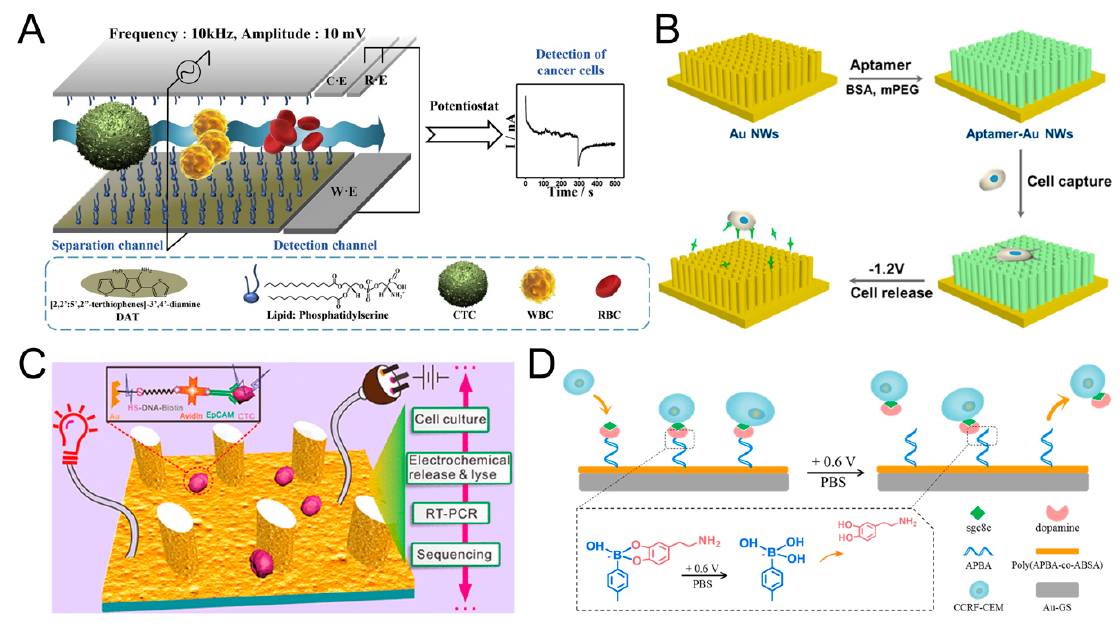
Figure 5. Other electrochemical detection methods of CTC. ( A ) Modified the surface of the channel with lipid bilayer, and realized CTC separation and detection by applying AC electric field. Reprinted with permission from ref [128]. Copyright 2019, Elsevier. ( B ) Fabricated gold nanowires coupled with aptamer, and achieved CTC capture and release. Reprinted with permission from ref [126]. Copyright 2017, American Chemical Society. ( C ) Set a series of elliptical columns on the surface of the PDMS chip, coated with Au, and realized the capture release and lysis of CTC. Reprinted with permission from ref [125]. Copyright 2017, American Chemical Society. ( D ) Modified APBA-dopamine-sgc8c on the surface of poly(APBA-co-ABSA), promoted the capture and fast, e ffi cient release of CTC. Reprinted with permission from ref [127]. Copyright 2019,